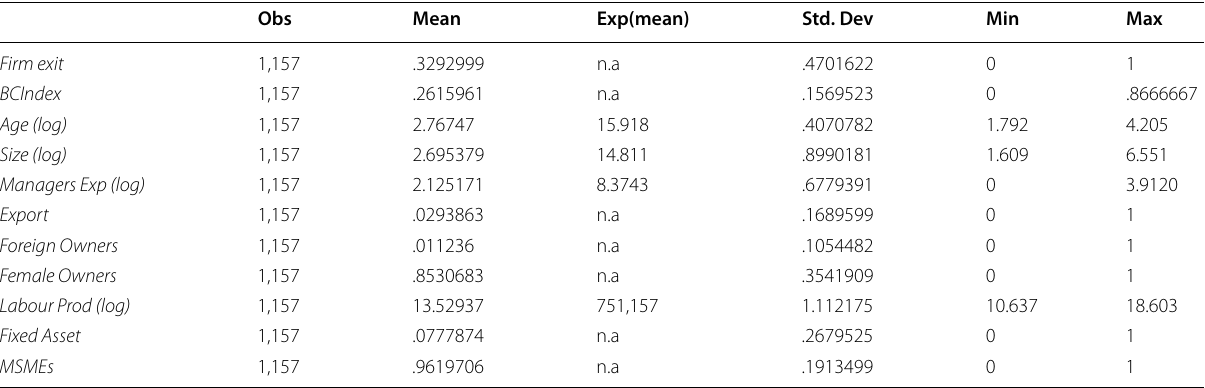
Table 3 Descriptive statistics of the